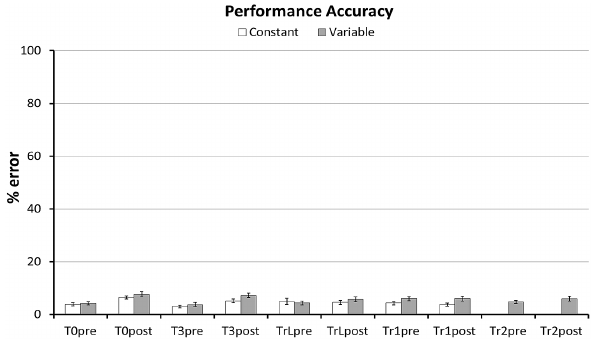
FIGURE 2 | Performance errors per task. Average percent of incorrect responses per task and Group. Error bars represent standard error of the mean. Incorrect responses varied between 3.0 and 7.7% (3.6–9.2 errors out of 120 responses) per block and were removed before further